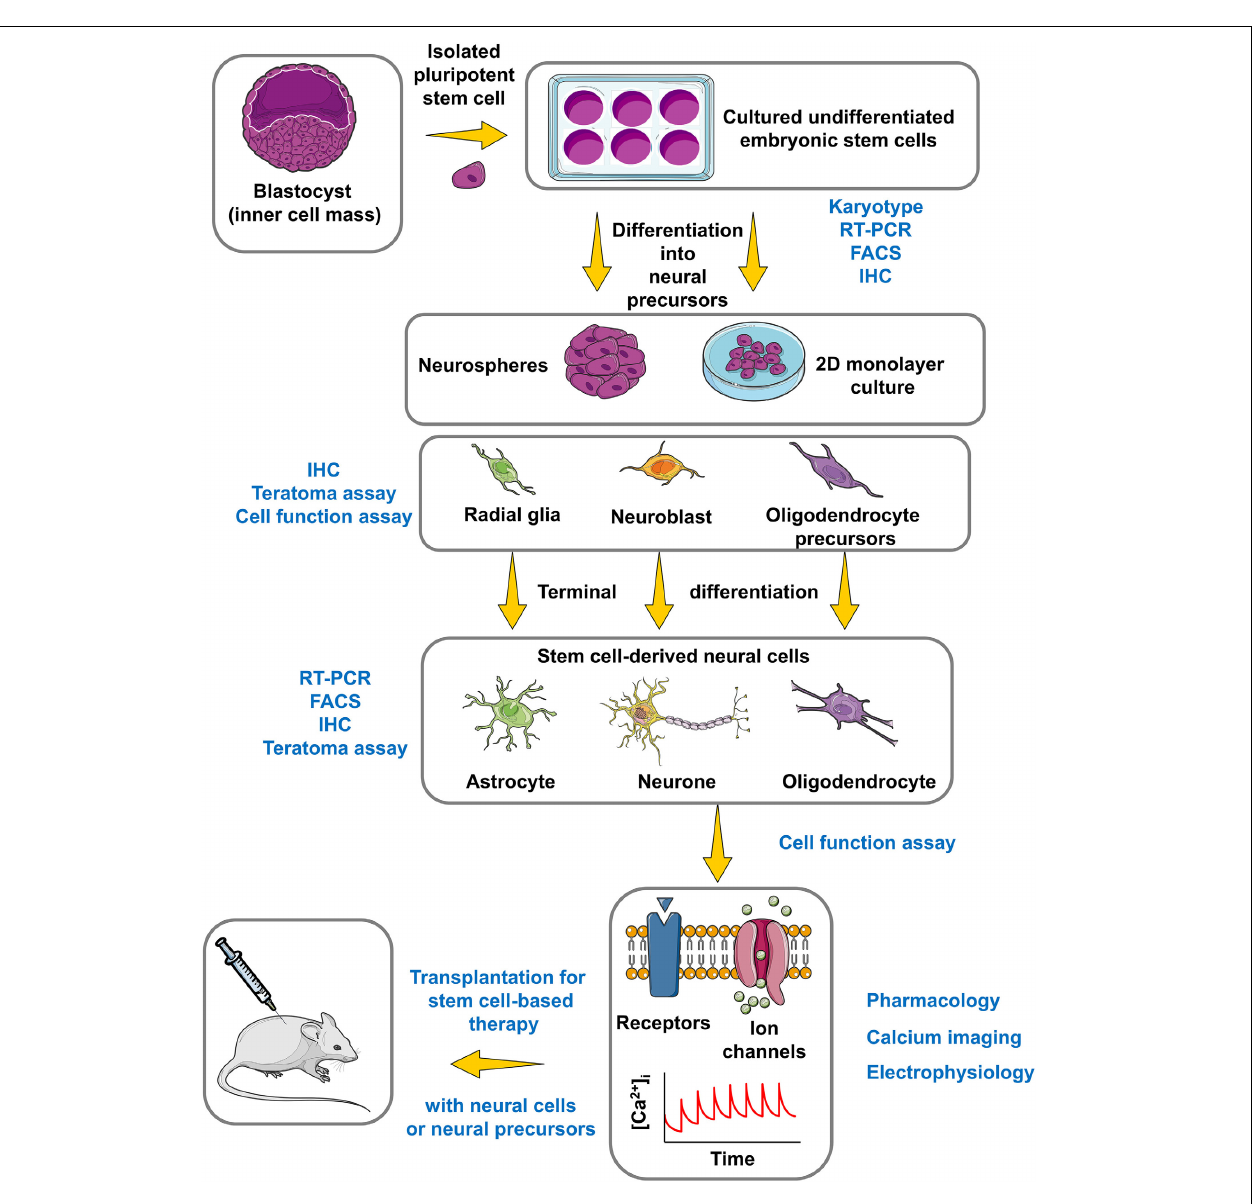
FIGURE 3 | Roadmap for the use of hESCs in CNS regenerative medicine. This simplified and summarized flowchart illustrates the major important phases to obtain, differentiate and characterize a stem cell model with regenerative potential for the CNS regarding stem cell-based therapy.